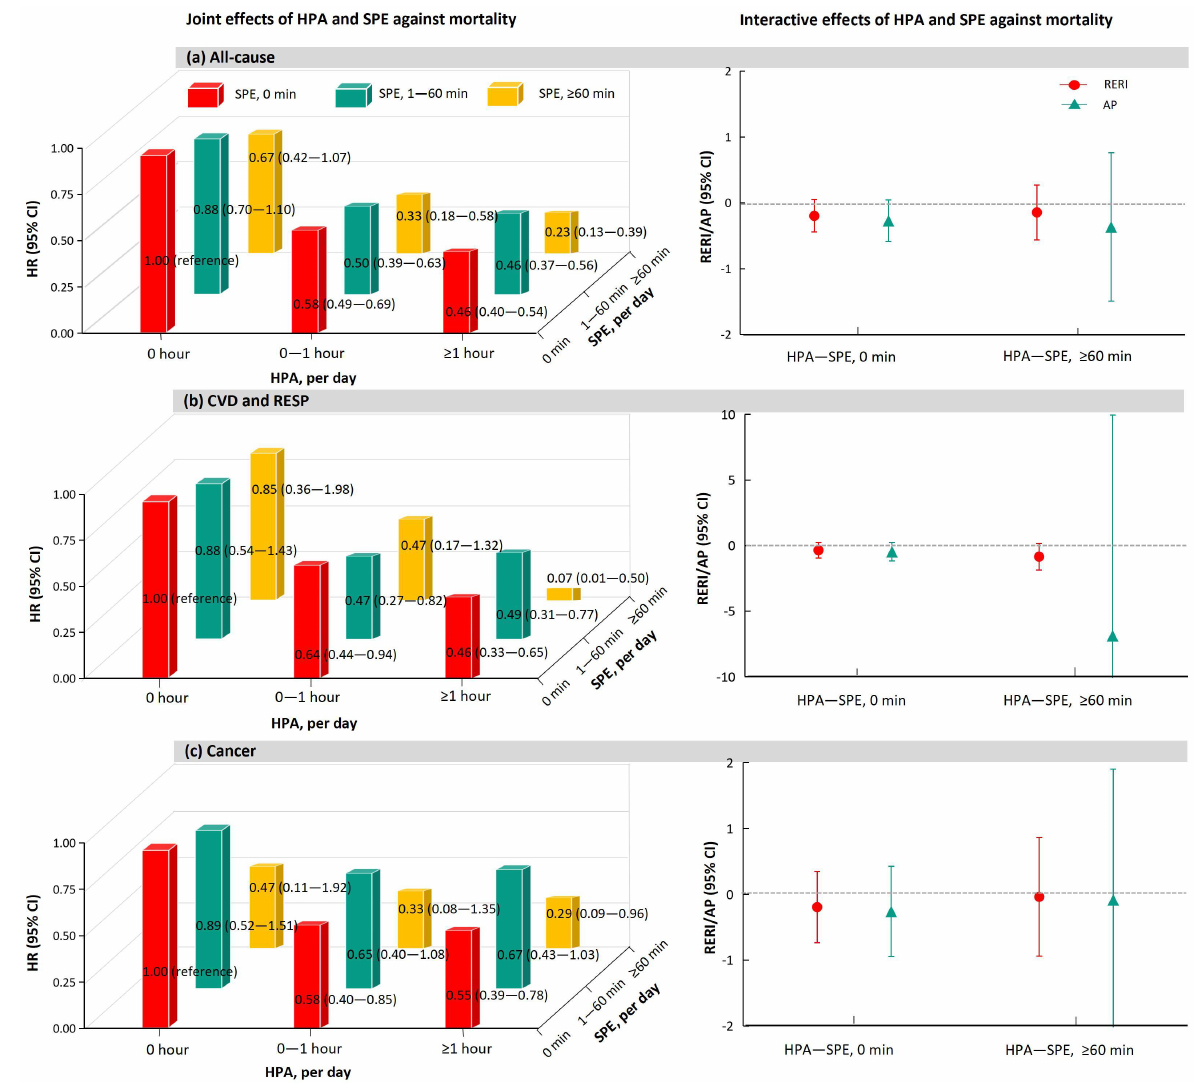
Figure 4. The joint and interactive effects between HPA and SPE against all-cause, CVD, RESP, and cancer mortality. We adjusted for gender, age, BMI, ethnicity, marital status, residential region, geolocation, education attainment, employment status, household income, smoking status, alcohol consumption, sleep duration, and chronic disease. Abbreviations: HPA, household physical activity; SPE, sport and physical exercise; CVD, cardiovascular disease; RESP, respiratory disease; BMI, body mass index; HR, hazard ratio; CI, confidence interval; RERI, relative excess risk due to interaction; AP, attributable proportion. Notes: We did not estimate joint and interactive effects for CVD and RESP mortality, respectively, because the number of RESP deaths for the group of HPA ≥ 1 h and SPE ≥ 60 min stratified by cross-classification was zero, which was insufficient to yield results. Therefore, we combined CVD with RESP to perform joint and interactive effect